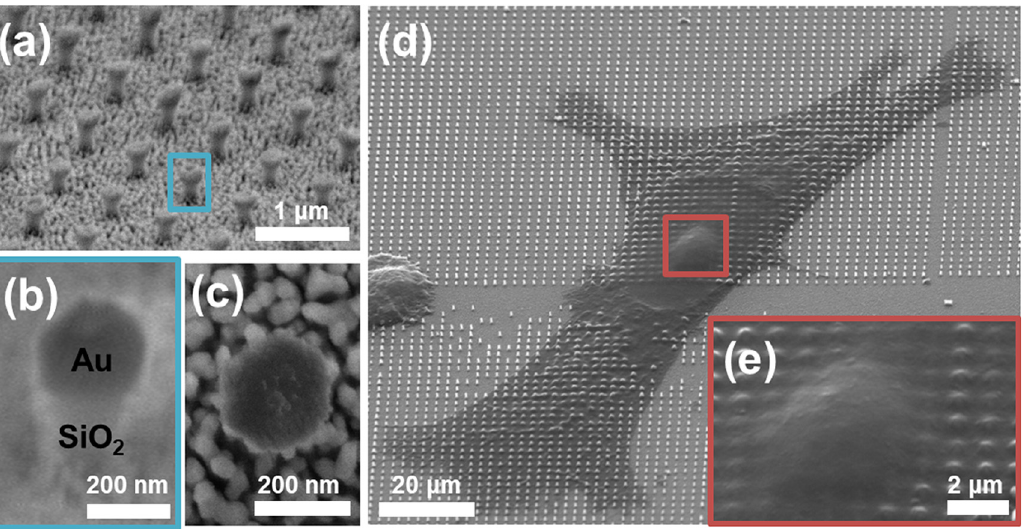
Figure 1: Scanning electron microscopy (SEM) images of vertically aligned SiO 2 nanopillars capped with gold nanodisks for intracellular fl uorescence localization imaging. (a) Distribution of a highly ordered array of vertical HNPs from an SEM image showing the homogeneity in the spacing (1 μ m), height (700 nm), and diameter (200 nm). (b) High-magni fi cation SEM image showing the successfully fabricated HNP morphology with clear distinction of a SiO 2 nanopillar and a gold nanodisk. (c) Top-view of a single HNP. (d) SEM image of HeLa cells interacting with nanopillars, showing excellent adhesion of the cells to HNPs. (e) Local deformation of the nuclear membrane and plasma membrane curved due to vertical